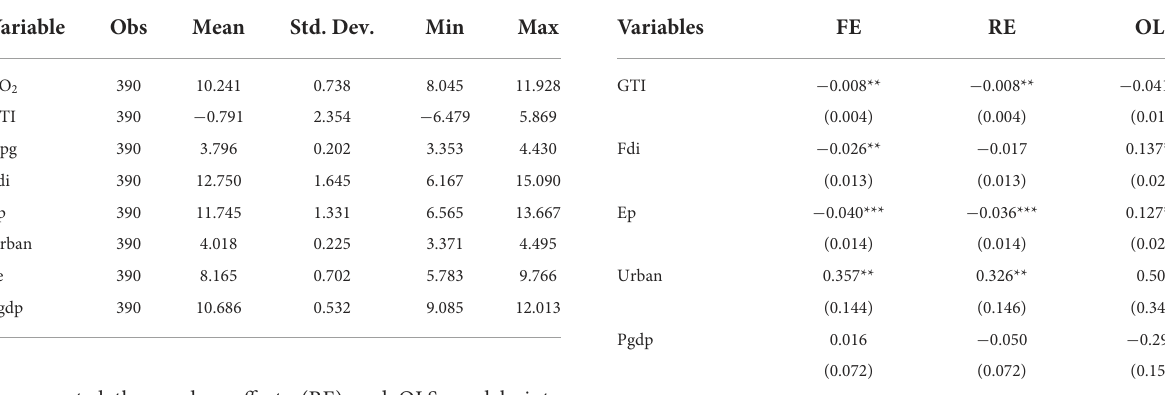
TABLE 2 Statistical description of variables. TABLE 3 Baseline regression